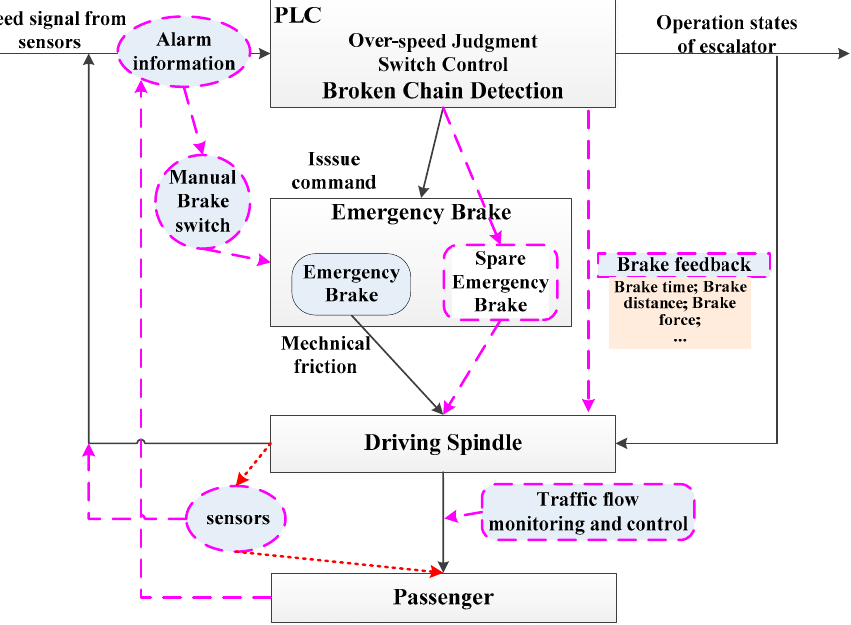
Figure 15. Improvement to escalator brake process.